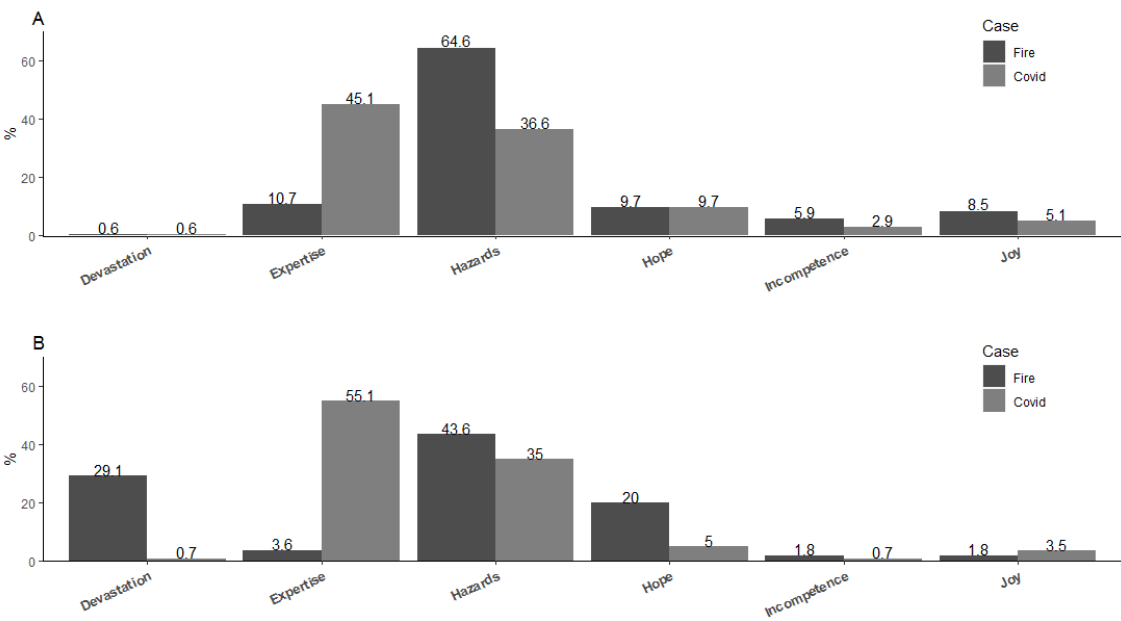
Figure 5. Connotative frames of articles, The New Daily ( A ) and Index ( B ). Connotative framing of the pandemic was similar on the two sites. Around half of the pictures suggested Expertise, and more than a third, Hazards. Additionally, it was striking that, on TND, Incompetence was twice as frequent in news items about the bushfires compared to those about the